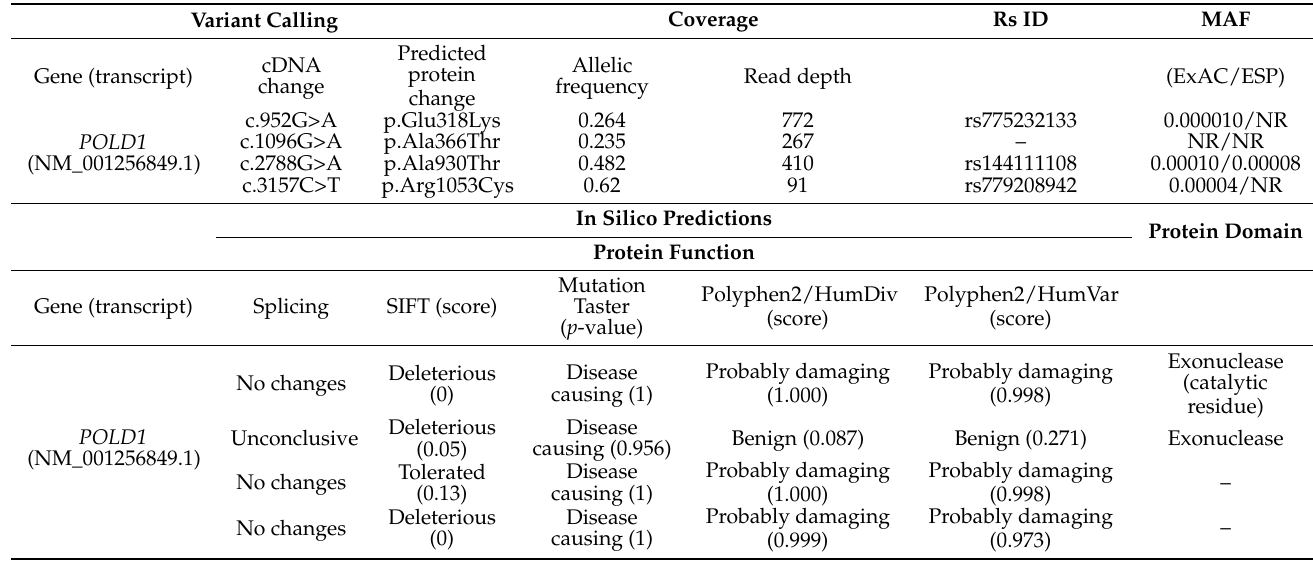
Table 3. POLD1 variants found in the analysis of the brain tumor of individual III.2. In silico predictions based on Alamut software.